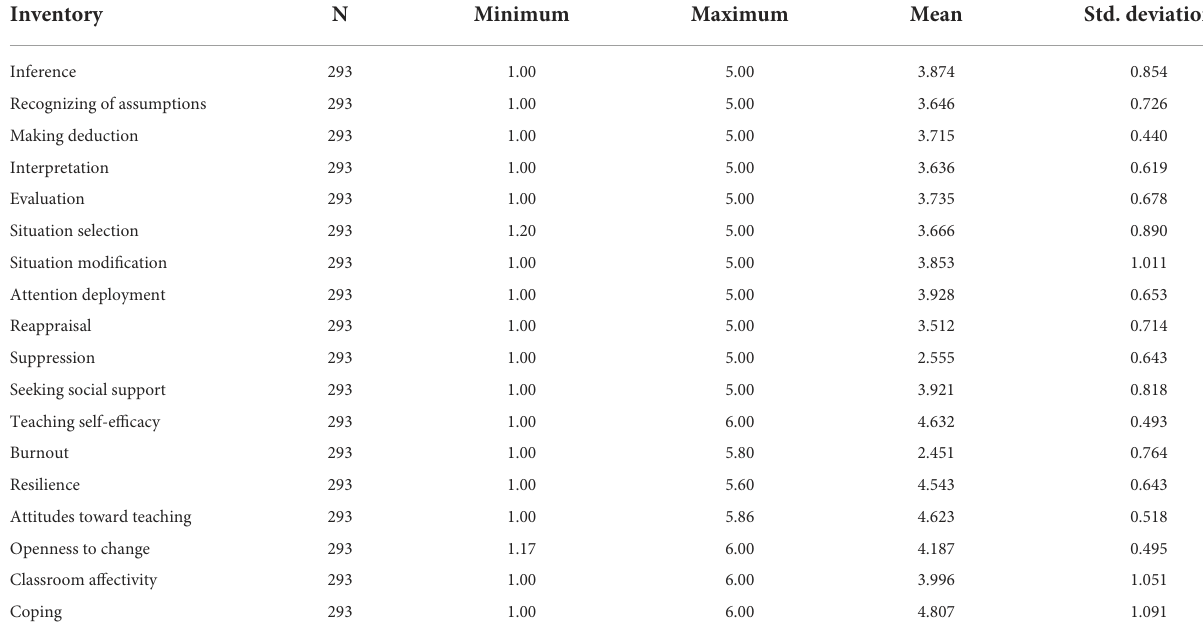
TABLE 1 The results of descriptive statistics of the english university teachers’ critical thinking, emotion regulation, and